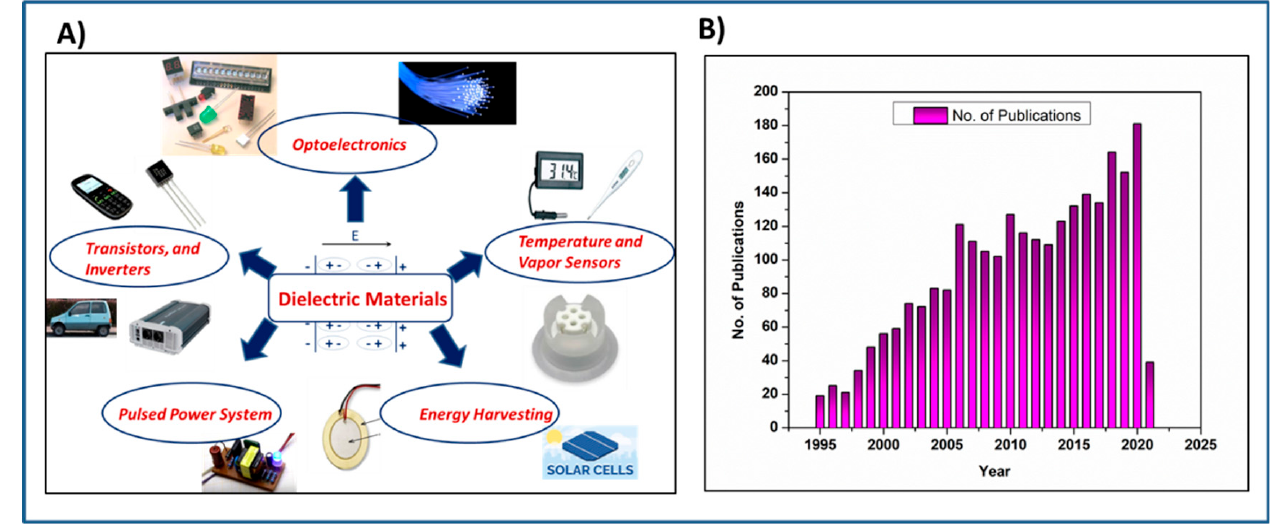
Figure 1. ( A ) The emerging applications of dielectric capacitors ( B ) Number of publications on “polymer dielectric capacitor” per year in the last 25 years.